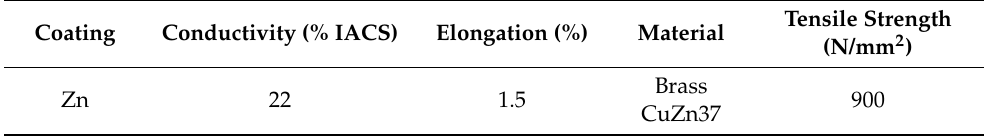
Table 1. Properties of coated copper wire used in the WEDM process. IACS refers to International Annealed Copper Standard. The conductivity in % IACS is calculated based on the conductivity of standard “pure copper” according to IACS.